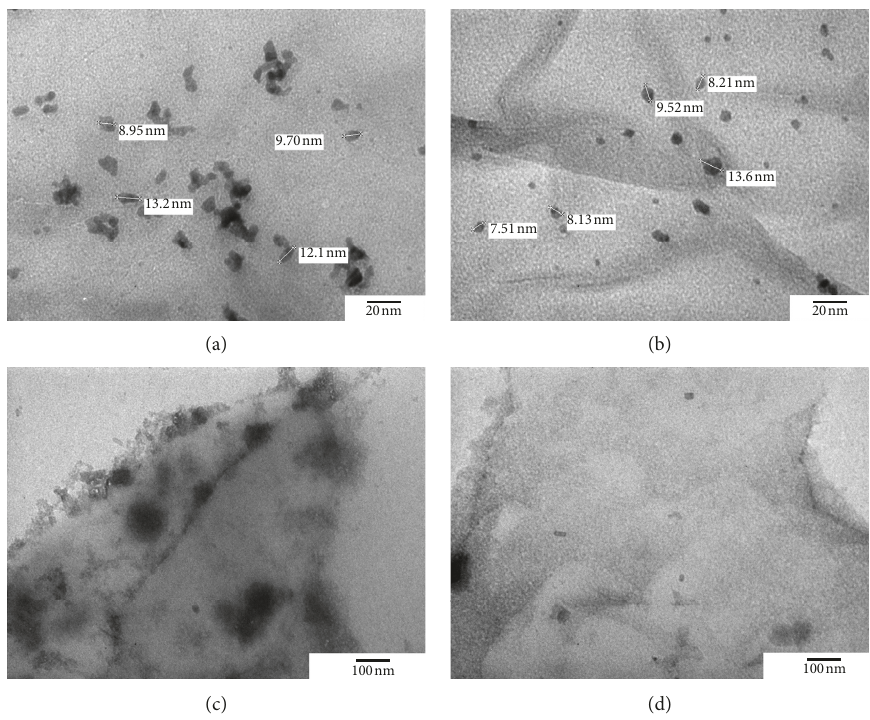
Figure 8: TEM images of PASGN.N and PASG.N catalysts before (a, b) and after 500 scanning cycles (c, d) in a (NaOH 0.5 M+C 1M) solution at a scan rate of 50mV · s − 1